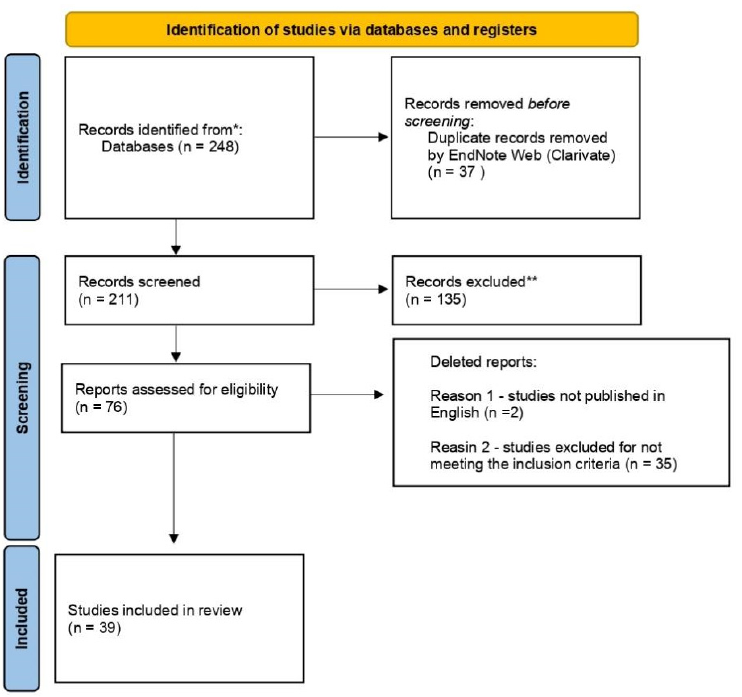
Figure 1. PRISMA 2020 flowchart for new systematic reviews only included database and registry searches [31] (accessed on 19 July 2022).